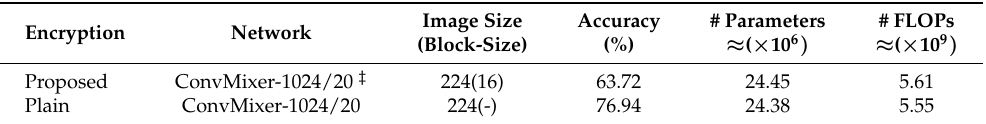
Table 2. Classification accuracy (%) on ImageNet of proposed privacy-preserving image classification method.